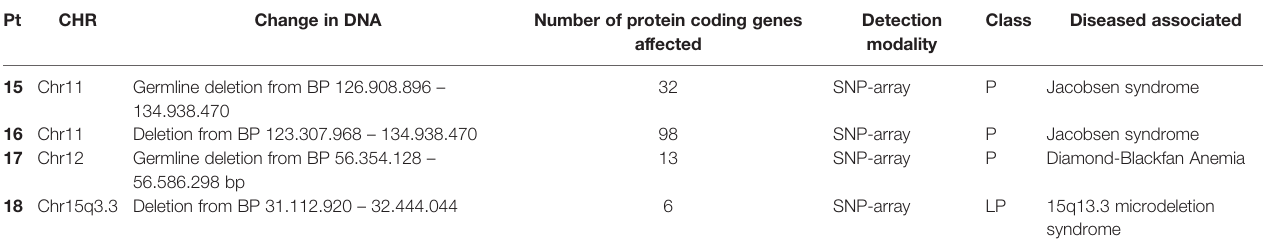
TABLE 3 | List of chromosomal aberrations.